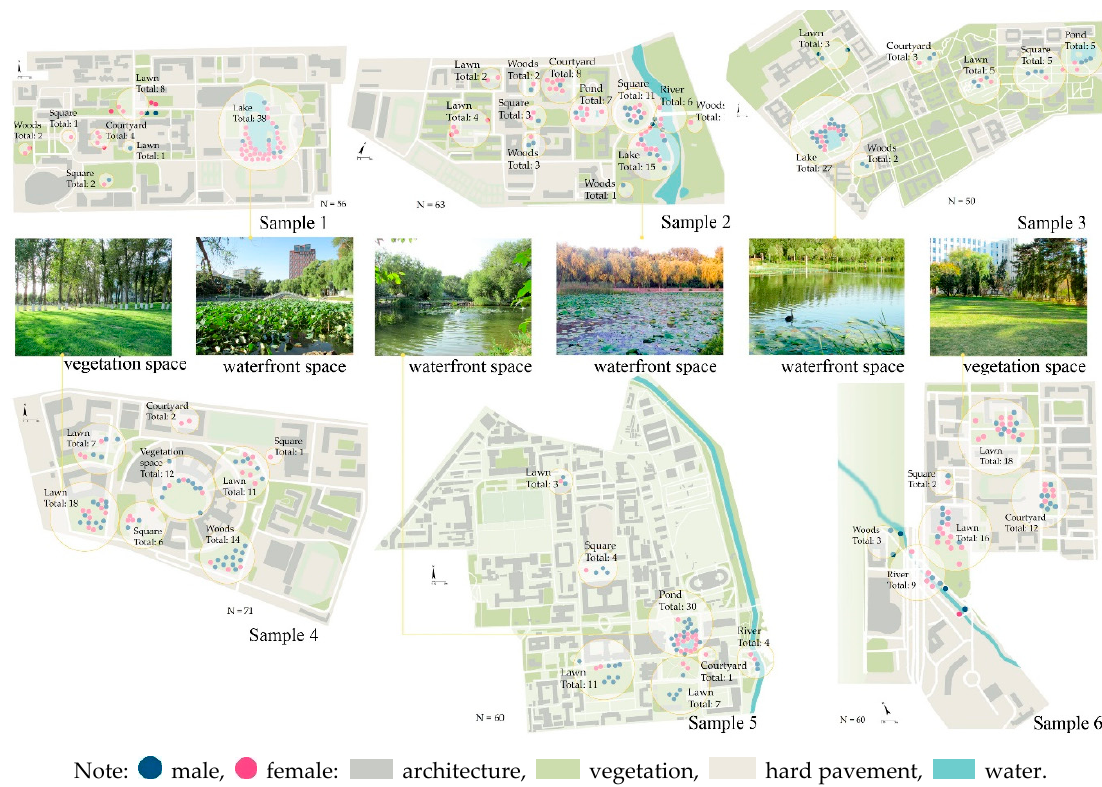
Figure 4. Preference of attention restoration space on university campus and examples of best perceived restorative spaces based on place-mapping.